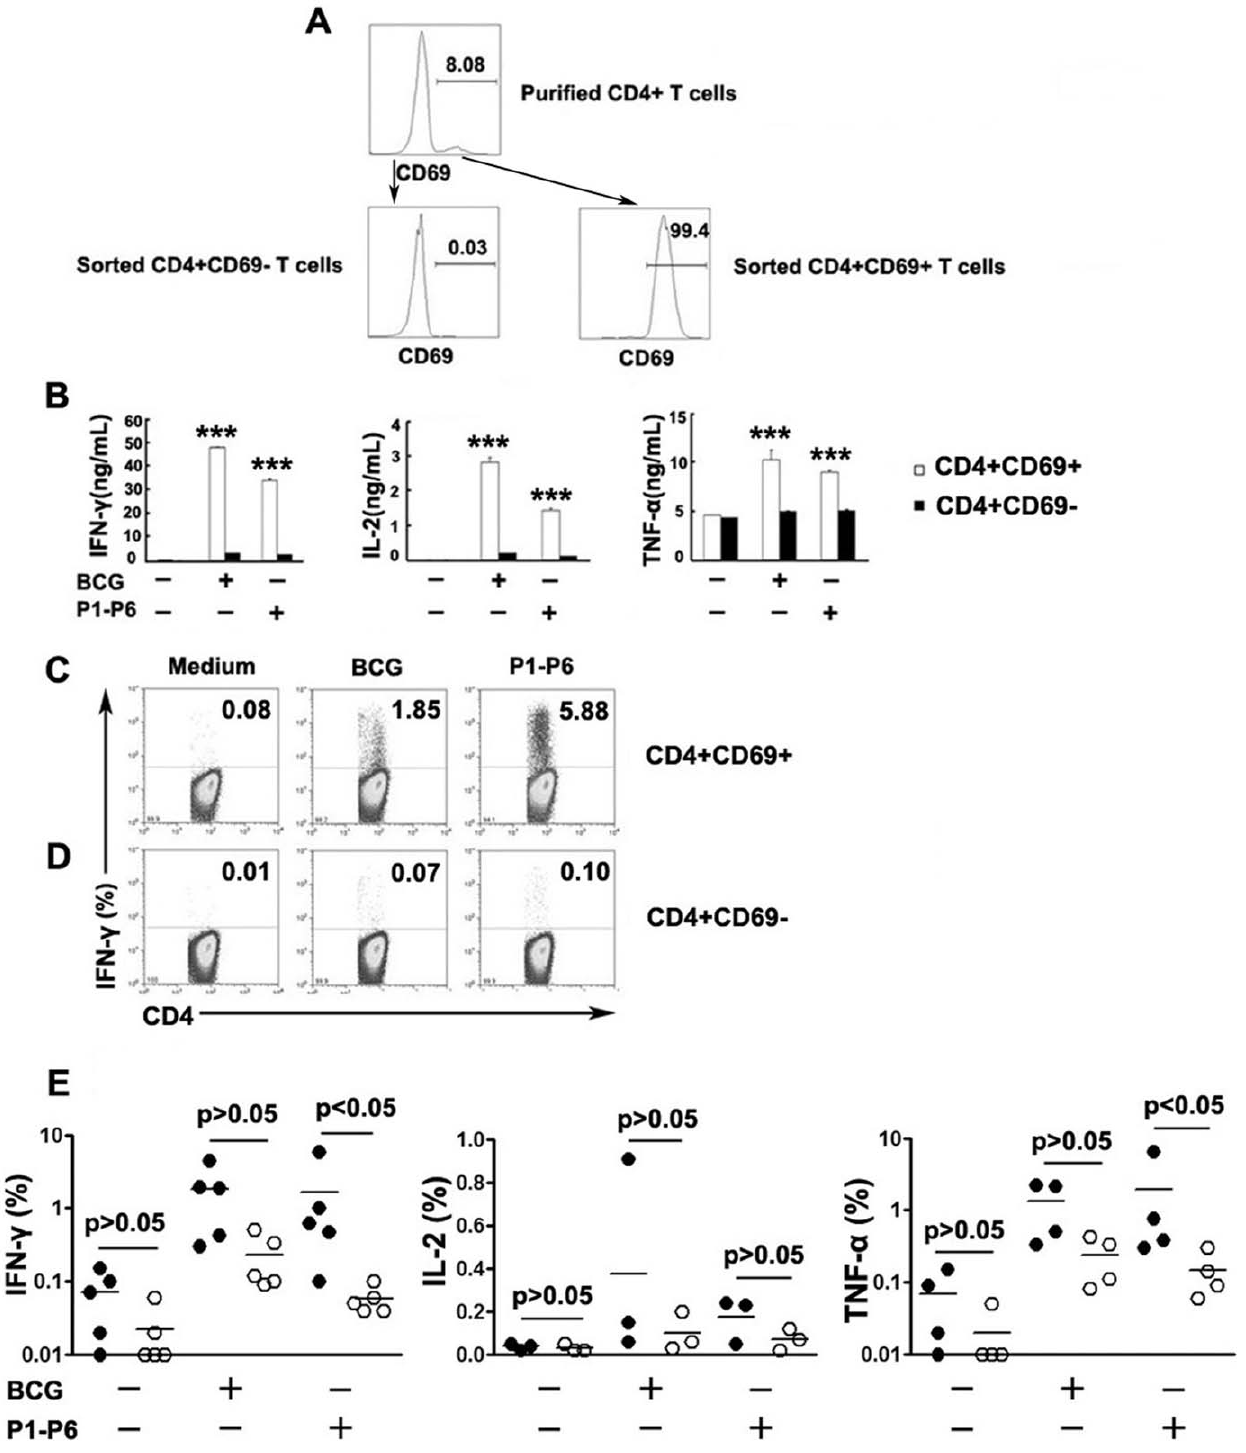
Figure 5. Effector memory CD4 + CD69 + T cells produced IFN- c in response to MTB-specific peptides. (A) PFCs were stained with CD4, CD69, CD45RA, CD45RO, CD127 and CD27. The expression of each marker within CD4 + CD69 + and CD4 + CD69 2 T cells was evaluated by FACS. Isotype controls are shown in gray and the expression of each marker is shown by dotted lines. (B) Mean value of expression of each marker on CD4 + CD69 + and CD4 + CD69 2 T cells. Differences between groups were assessed by the Wilcoxon matched pairs test (Two-tailed). (C) PFCs stimulated with P1-P6 were gated on CD4 + CD69 + IFN- c + and CD4 + CD69 + IFN- c 2 cells and analyzed for the expression of memory markers CD45RA, CCR7, CD62L and CD27, as indicated. Upper panel represents the control. Lower panel represents the expression of each marker. CD4 + CD69 + IFN- c + T cells are shown in black, whereas CD4 + CD69 + IFN- c 2 T cells are depicted in gray. The expression of each marker within CD4 + CD69 + IFN- c + T cells was overlaid with CD4 + CD69 + IFN- c 2 T cells. The numbers in the quadrants indicate the percentage of cells among CD4 + CD69 + IFN- c + T cells. One representative result from ten independent experiments with similar results is shown.